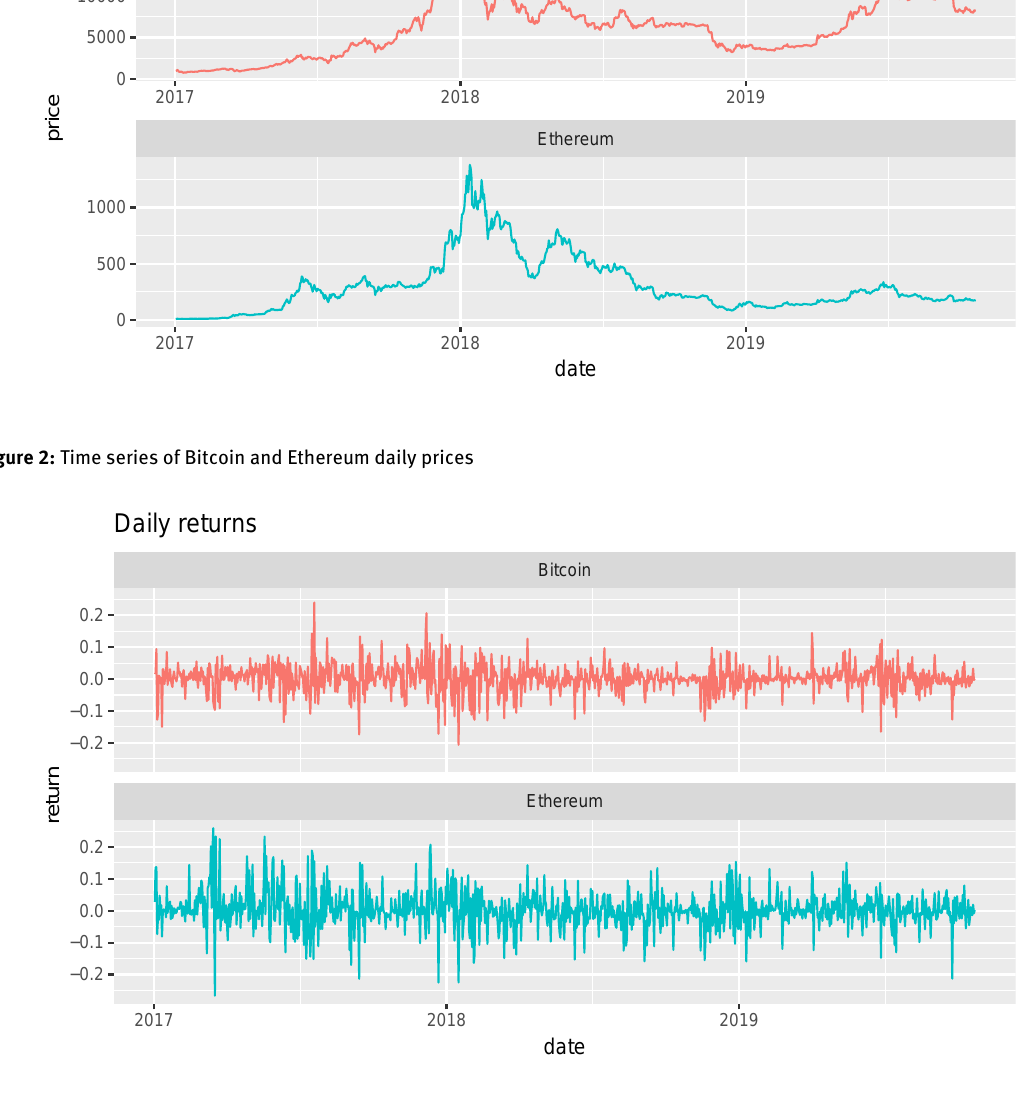
the annualized mean returns are also rather different. The annualized mean returns are 0.78 (Bitcoin) and −0.08 (Ethereum), the annualized standard deviation are closer to the daily values: 0.79 and 0.86. The first order autocorrelation is again small (−0.015 and −0.002), the autocorrelation of absolute returns is higher than for daily data (0.245 and 0.242). Figures 6 and 7 show the high-frequency time series of prices and re- turns. Figure 8 shows the scatterplot of the empirical edfs of Bitcoin and Ethereum returns. The structure appears to be more symmetric than for daily data. The estimated copula densities are depicted in figure 9 (left: binomial generator, right: negative binomial generator). The nonparametrically estimated densities are rather dissimilar. The tail dependence symmetry